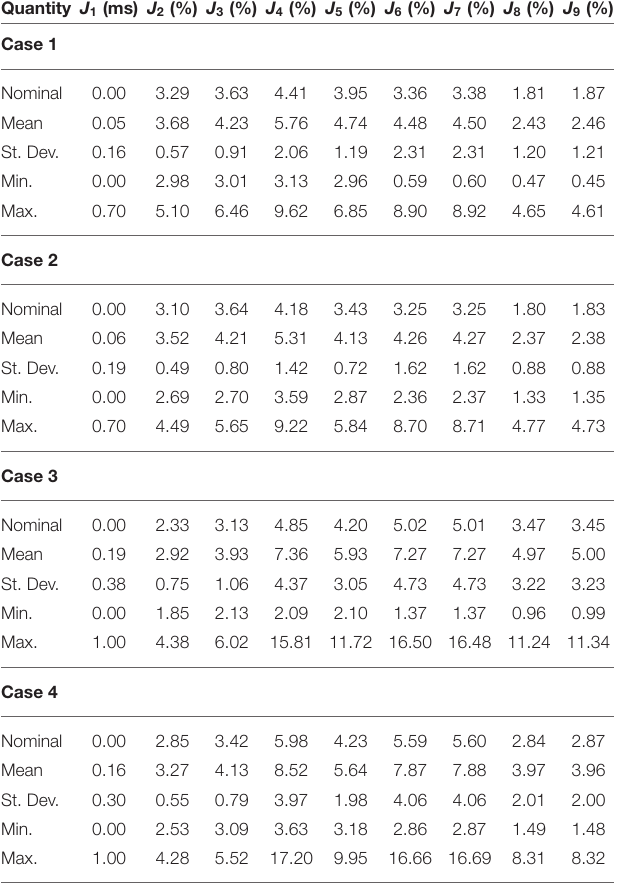
TABLE 4 | vRTHS evaluation criteria for the partitioning cases of Table 2